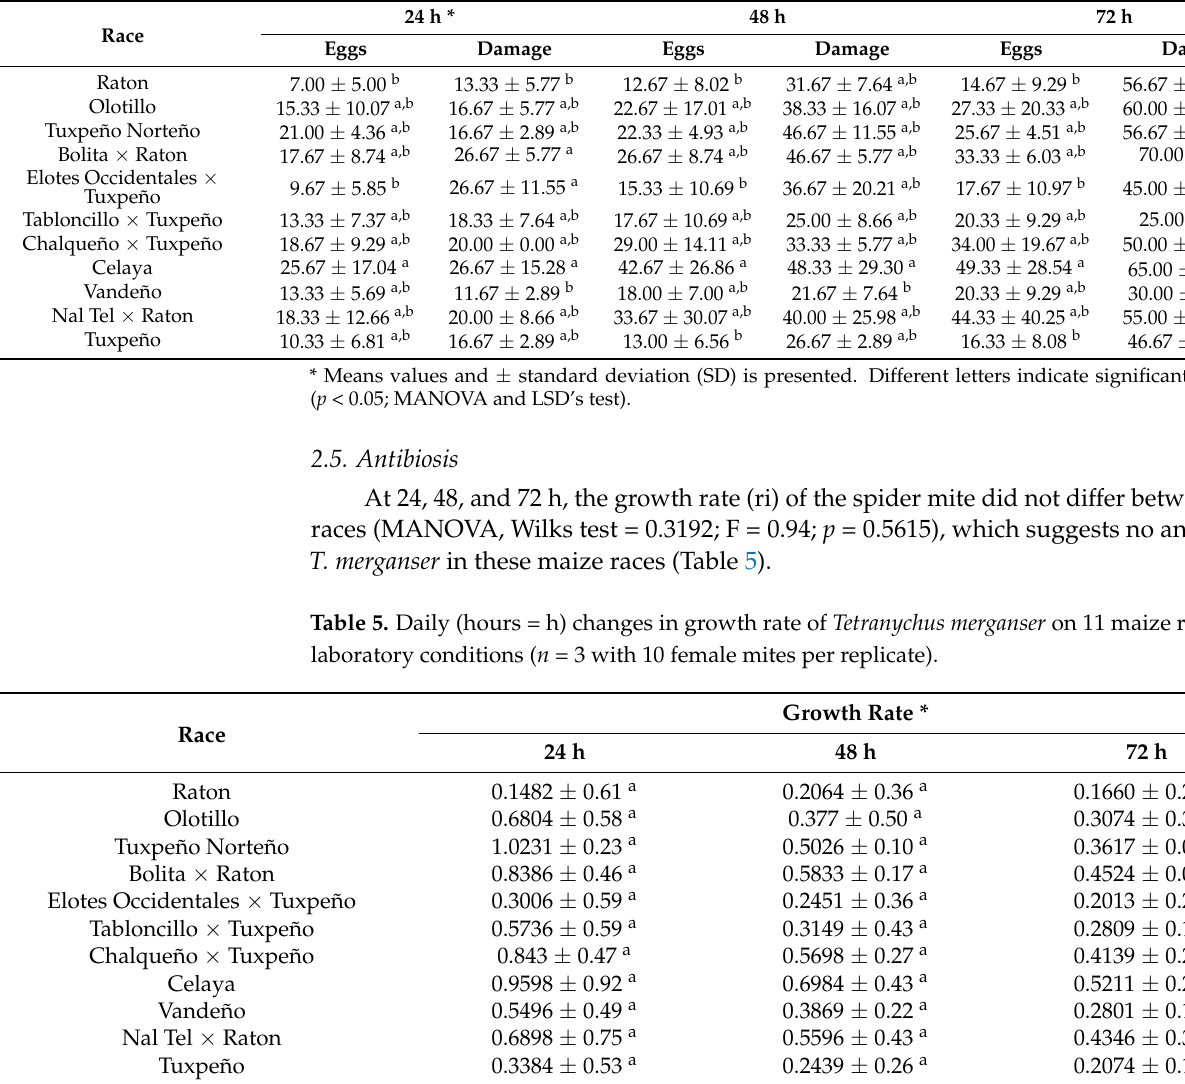
Table 4. Daily (hours = h) mean number of eggs laid and percentage of feeding damage of Tetranychus merganser in 11 maize races under laboratory conditions (n = 3 with 10 female mites per replicate).